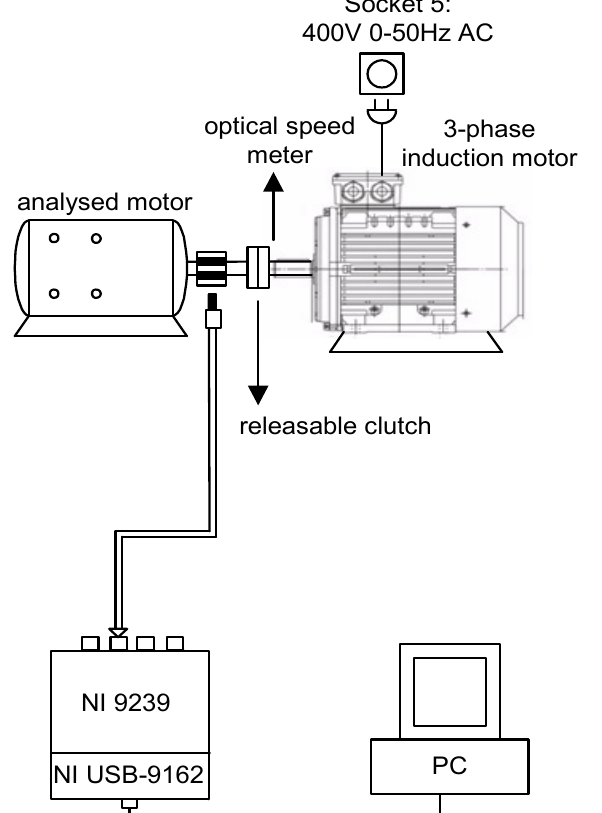
Figure 15. Experimental setup for the measurement of the moment of inertia of the rotor of an electric motor.